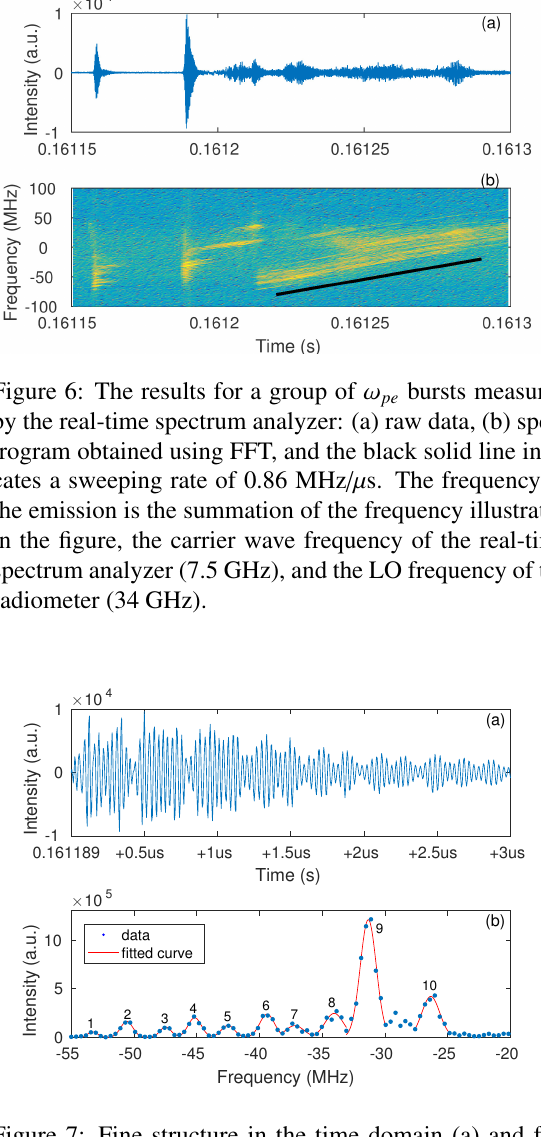
Figure 7: Fine structure in the time domain (a) and fre- quency domain (b) of the ω pe bursts within a time scale of 3 µ s shown in Figure 6. The frequency of the emission is the summation of the frequency illustrated in the figure, the carrier wave frequency of the real-time spectrum ana- lyzer (7.5 GHz), and the LO frequency of the radiometer (34